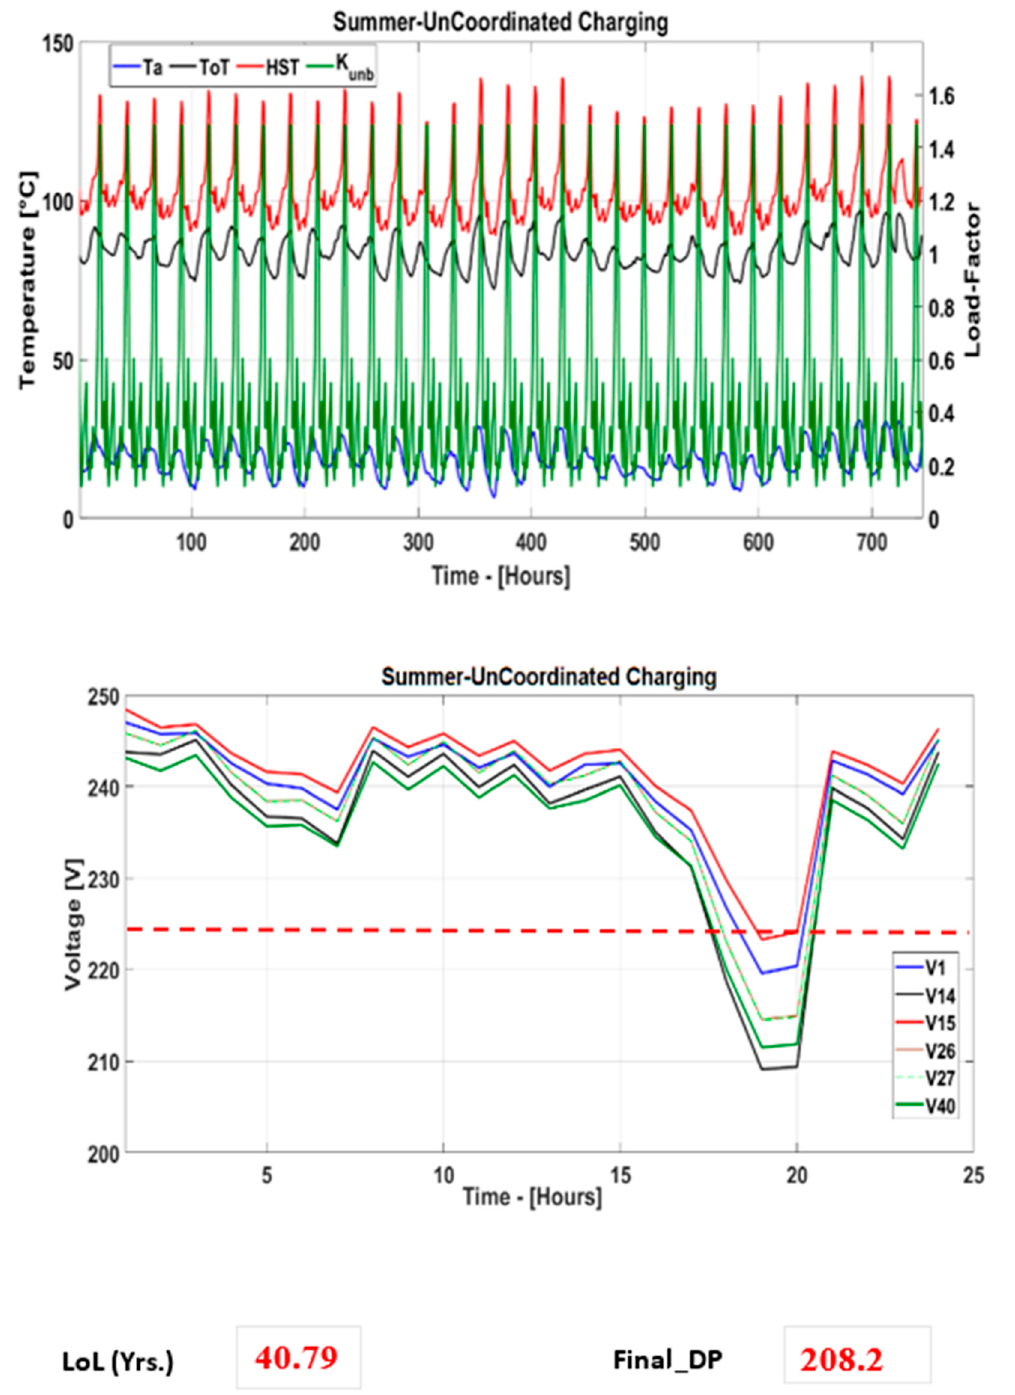
Figure 5. Output under uncoordinated charging across selected households, in summer, without BESS.